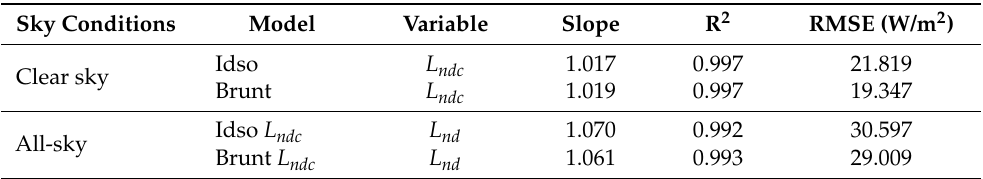
Table 6. Comparison of statistical estimators of the two calibrated daylight downward longwave irradiance models under (a) clear-sky and (b) all-sky conditions at Athalassa using the current data set